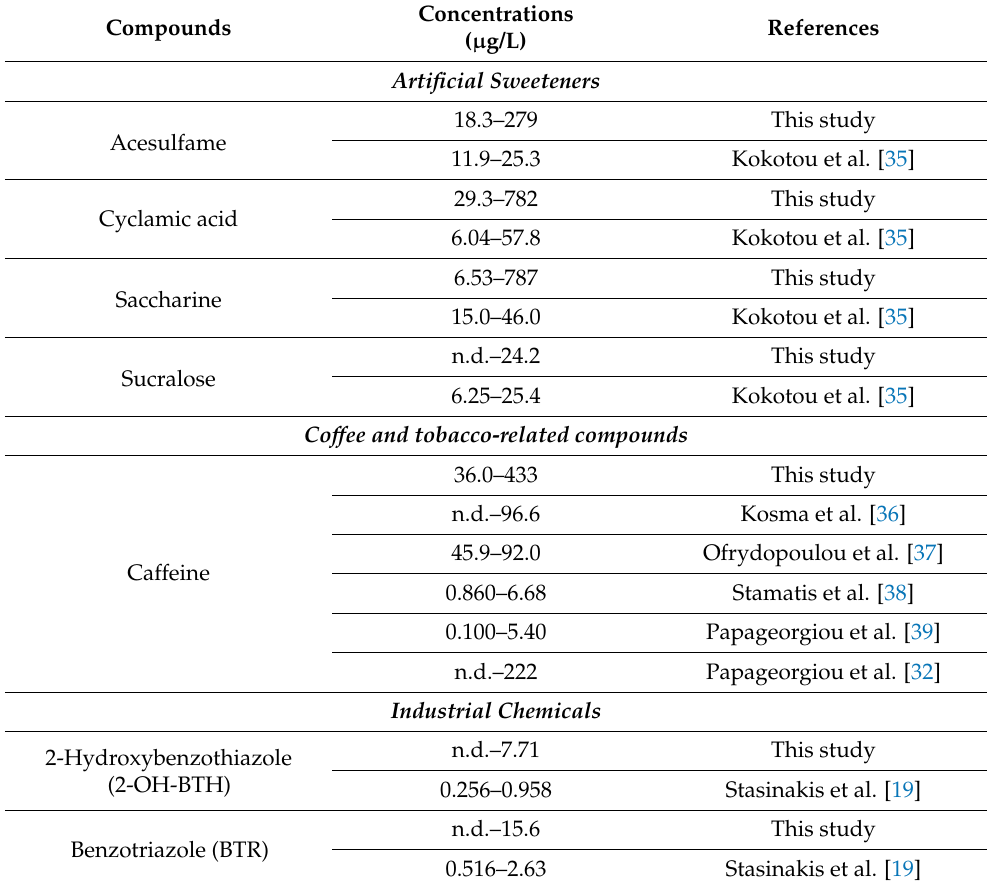
Table 3. Comparison of the concentration levels of the studied emerging contaminants in Greek raw municipal wastewater with those found in